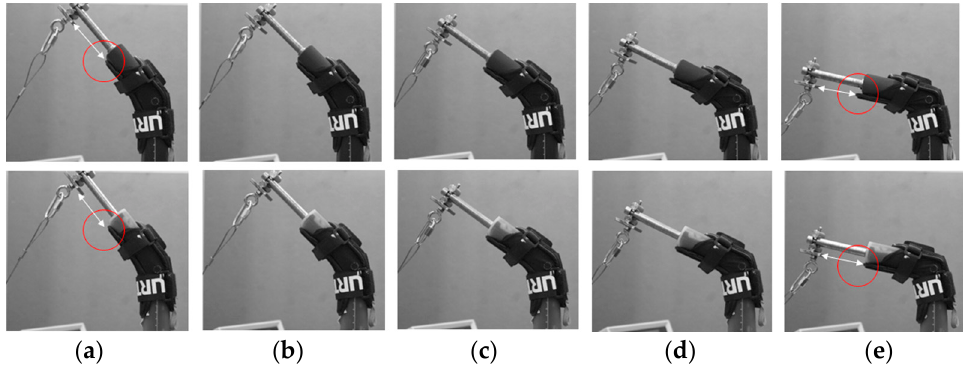
Figure 5. Video sequence at ( a ) 0 s, ( b ) 10 s, ( c ) 20 s, ( d ) 30 s, ( e ) 40 s of the short protector on the rigid ( top ) and compliant ( bottom ) surrogate. All of them are moderate strapping condition. Red circles highlight protector slippage. White line indicates measured